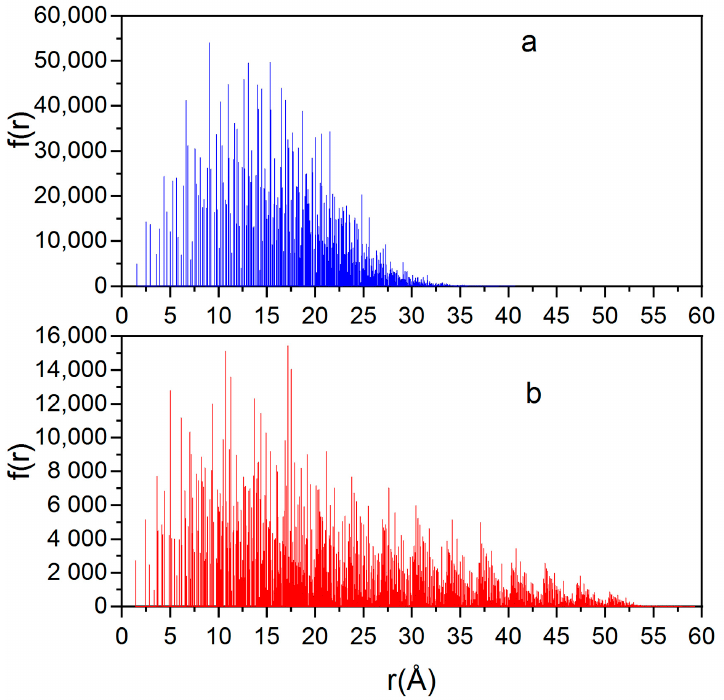
Figure 2. Interatomic distance histograms of ( a ) diamond D2 and ( b ) graphite